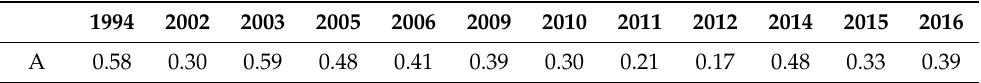
Figure 3. Using the east branch glacier of UG1 (A) in 2015 as an example, the spatial variation of the albedo in the central line area of the glacier (a) and mean albedos in 50 m elevation intervals along the centerline of the glacier (b). The error bars show the standard deviation of the distribution. The arrow indicates the threshold of the glacier ice region and snow-covered region, with a value of about 0.33. Table 4. Albedo threshold ( α thre ) of the glacier ice region and snow-covered region, taking the east branch glacier of UG1 (A) as an example.